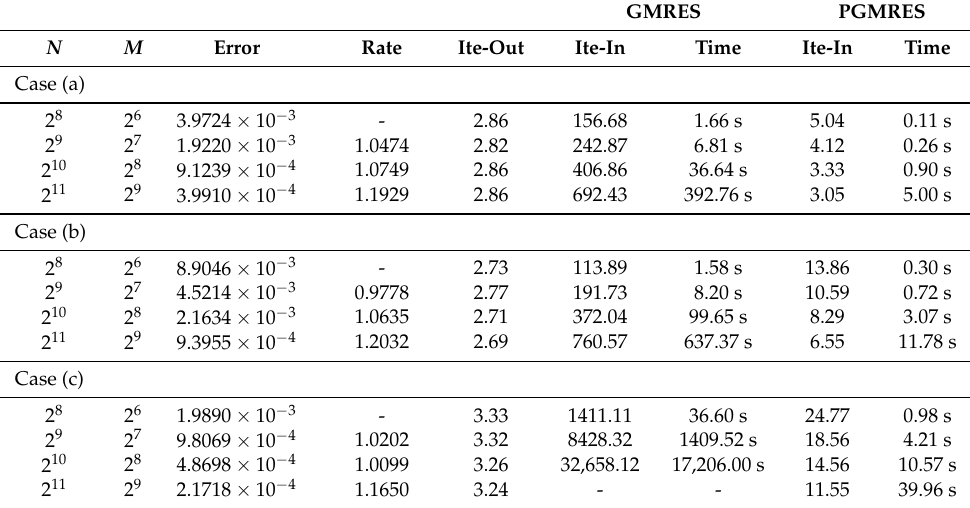
Table 2. Numerical results from the GMRES